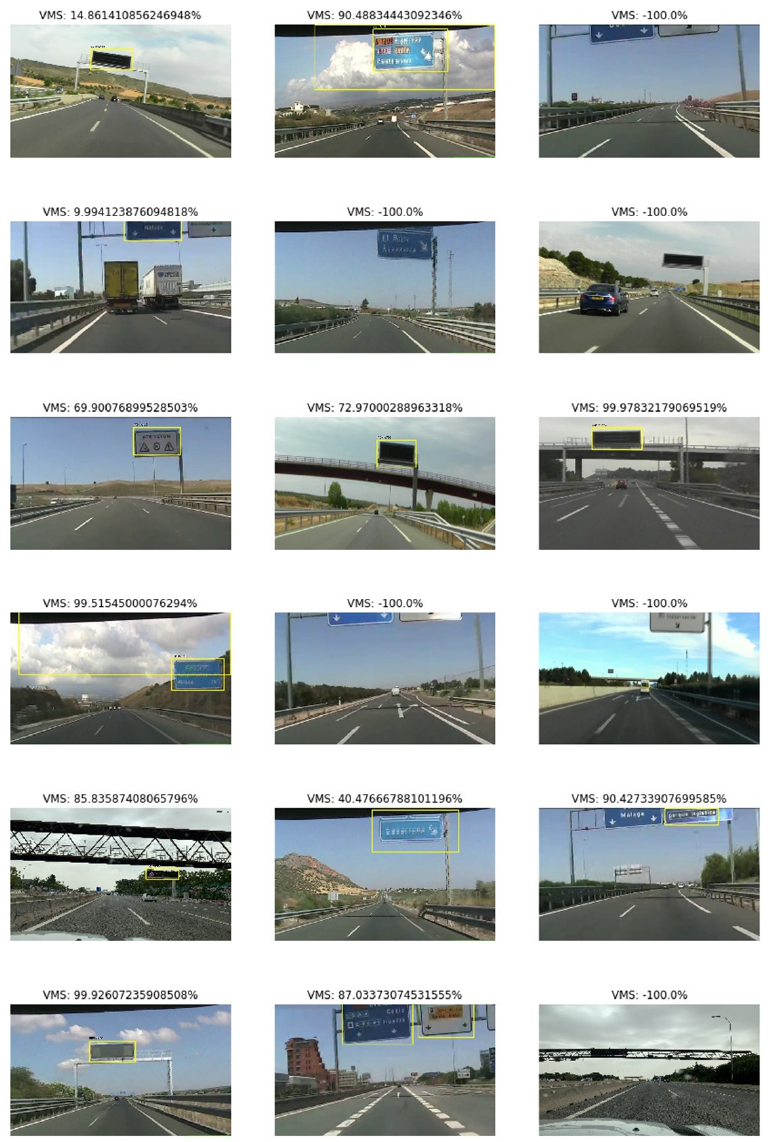
Figure 5. Some examples of VMS detection.